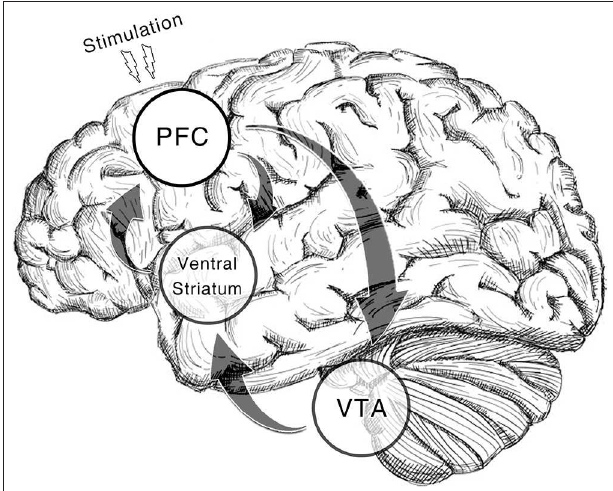
FIGURE 1 | Dopamine reward system involved in the therapeutic effect of NIBS. In the illustrated pathway, dopaminergic neurons in ventral tegmental area (VTA) projects the reward signal to medium spiny neurons (MSNs) in ventral striatum by which the cortico-striatal connection is modulated. While prefrontal regions (pyramidal neurons) including dorsolateral prefrontal cortex (DLPFC), anterior cingulate cortex (ACC), and medial prefrontal cortex (mPFC) give feedback to these regions (Gorelova and Yang, 1996; Frankle et al., 2006). With non-invasive brain stimulation alters activation in